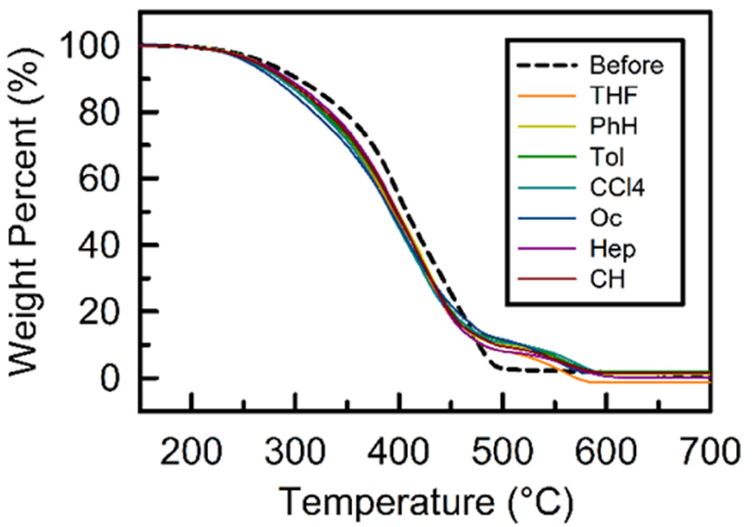
Figure 7. TGA cures of adhesive before and after different solvent dissolution and